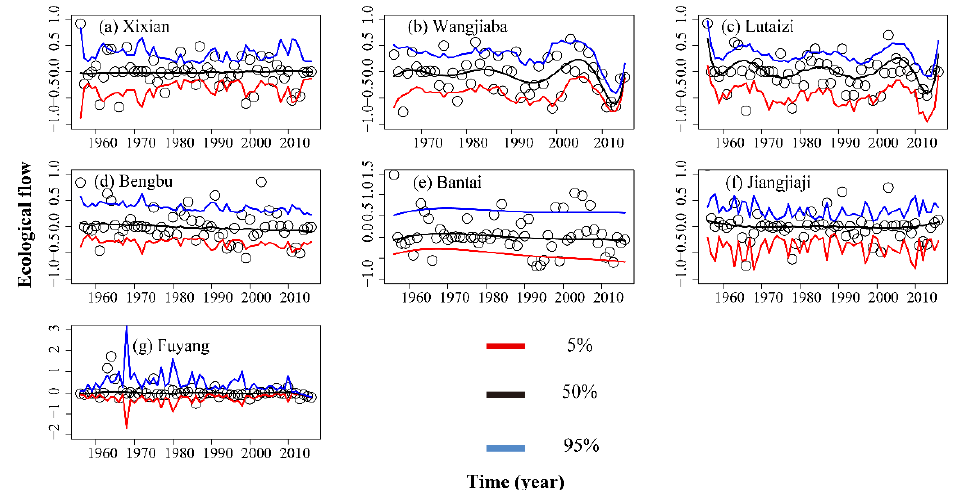
Figure 15. Centile curves of nonstationary ecological instream flow with climate factors.